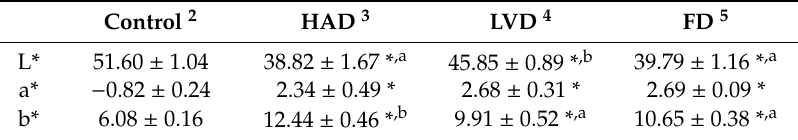
Table 3. Analysis of color parameters in the yellow croakers by various drying methods